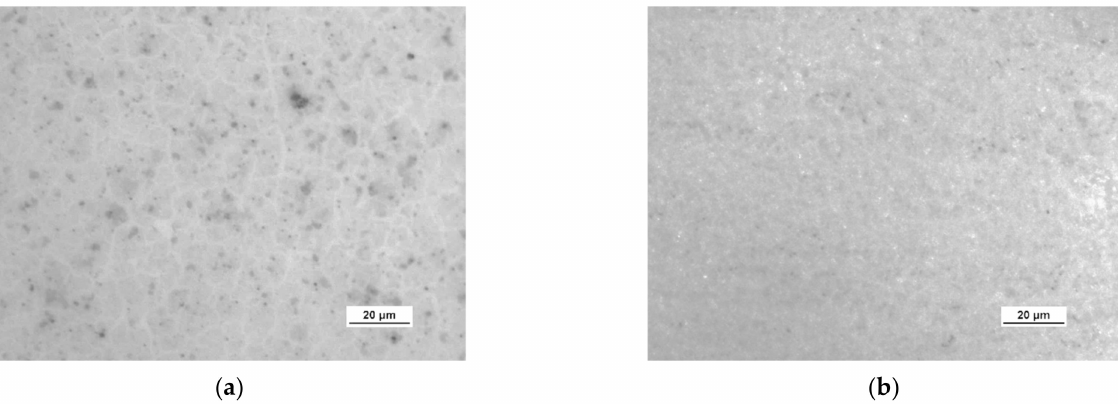
Figure 12. Optical images of the surface microstructure of: ( a ) HSMG ® and ( b ) CVD graphene transferred to 5% HF acid-etched Al 2 O 3 ceramics.